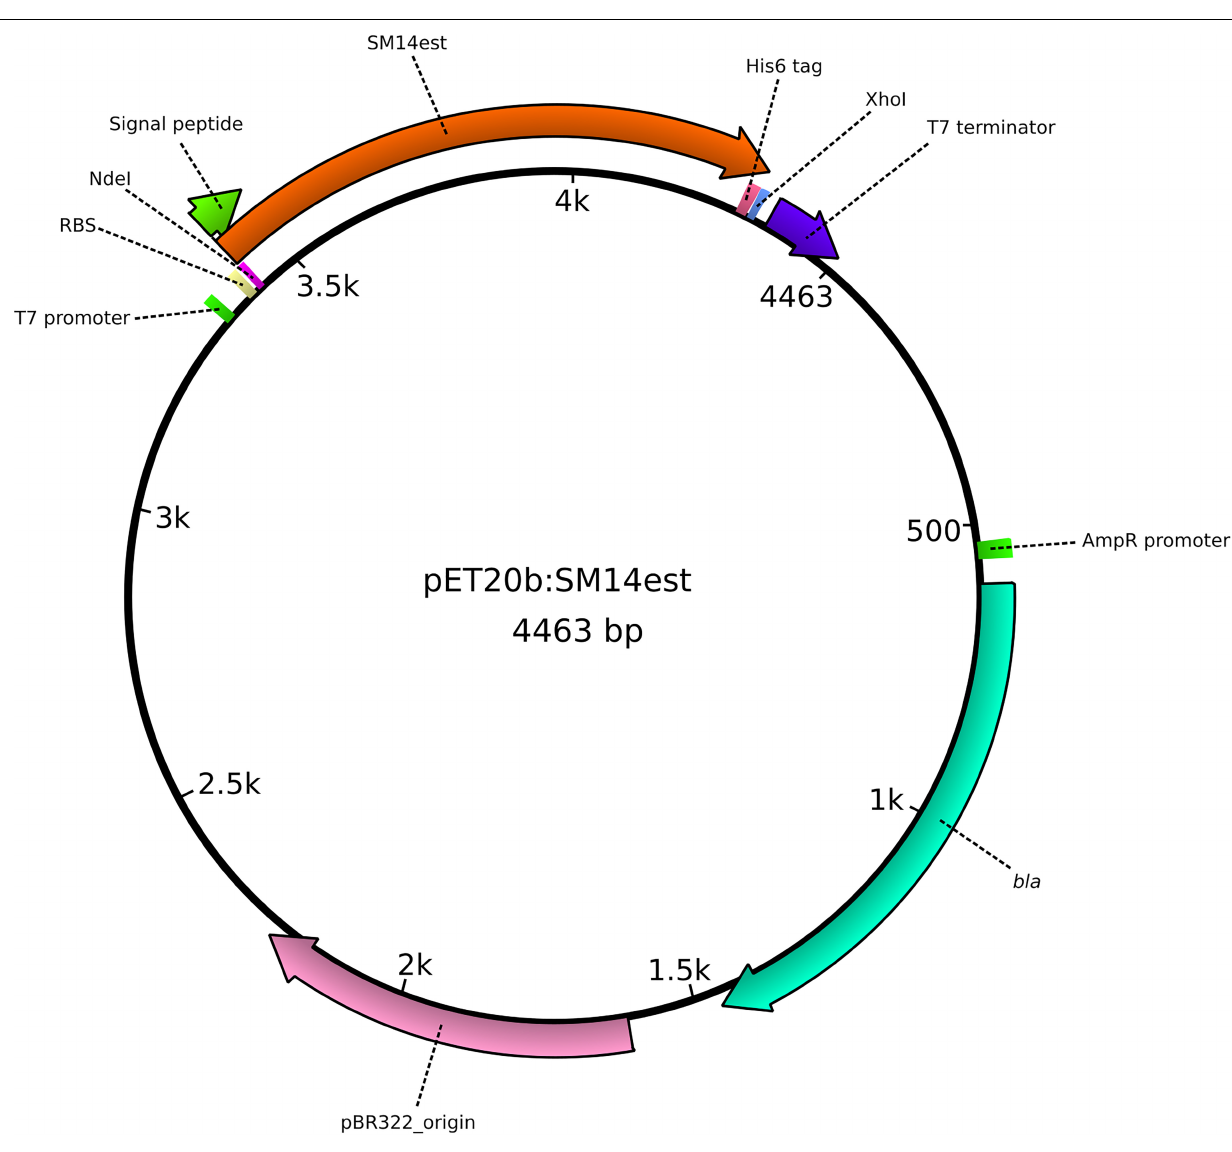
insert region of the plasmid, amplified using the T7 standard vector primers ( Supplementary Table S2